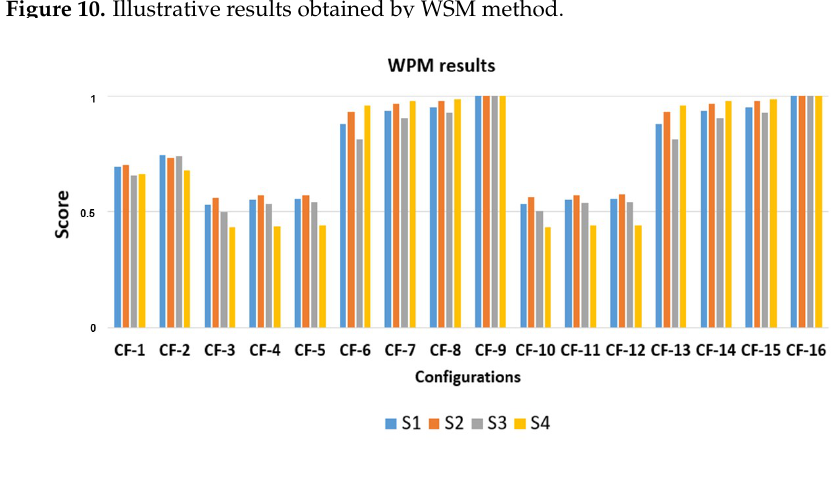
Figure 11. Illustrative results obtained by WPM method.